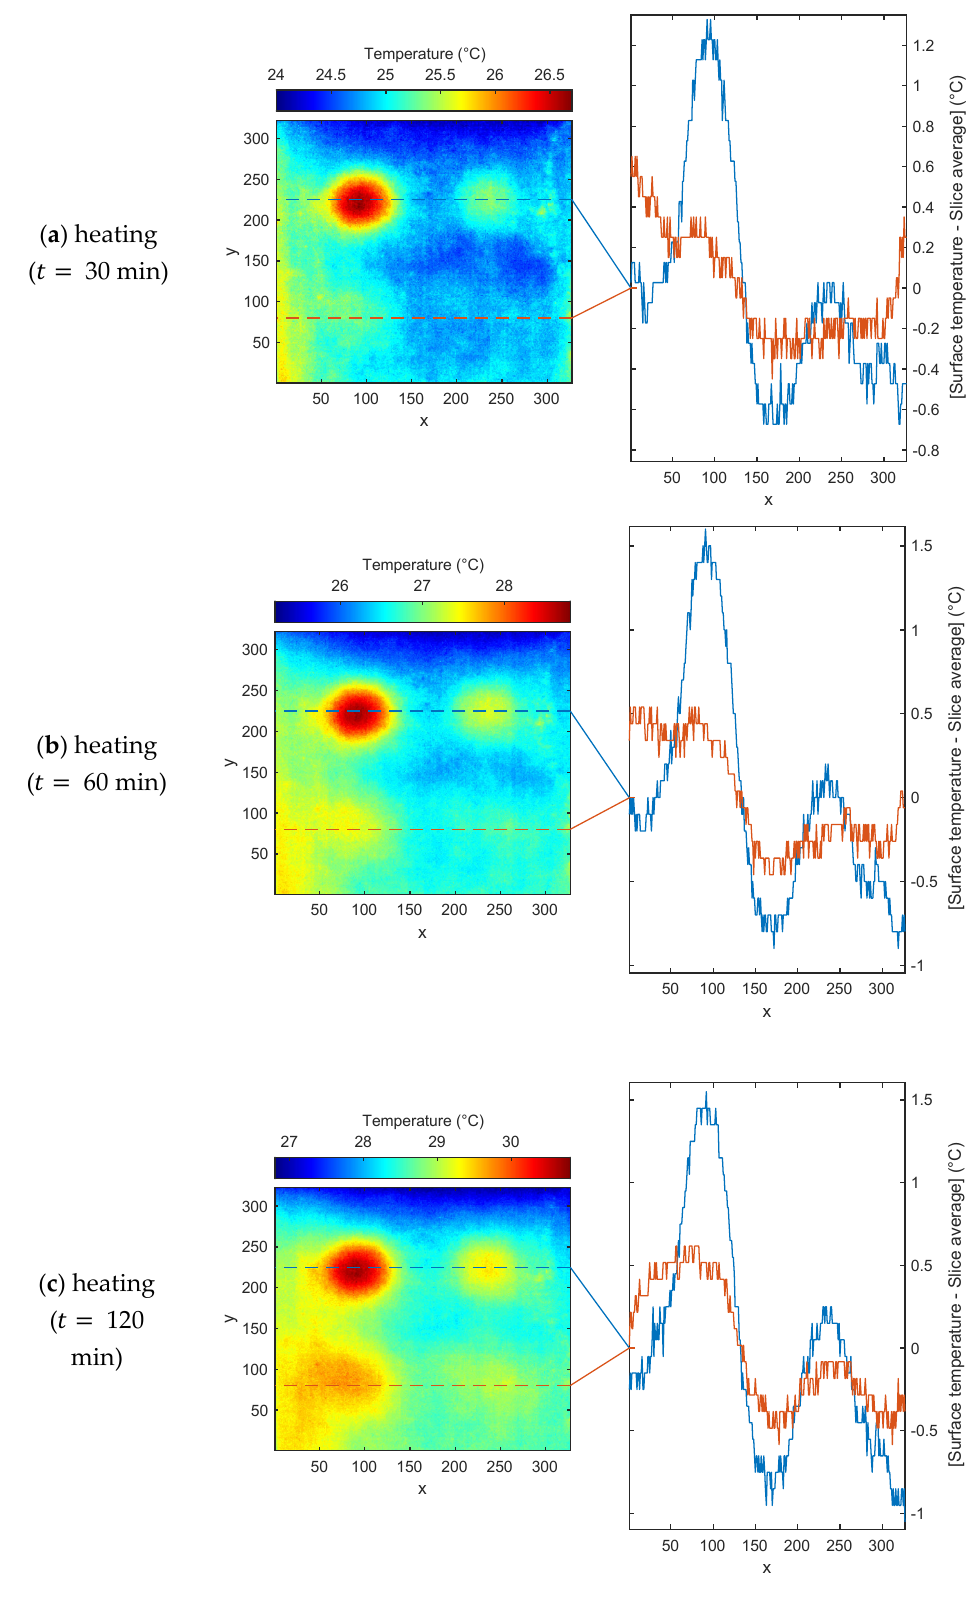
Figure 12. Selected thermal images at the end of ( a ) 0.5 h of heating, ( b ) 1 h of heating, and ( c ) 2 h of heating, in which the blue and red dashed lines correspond to temperature profiles over the sound and defective areas.